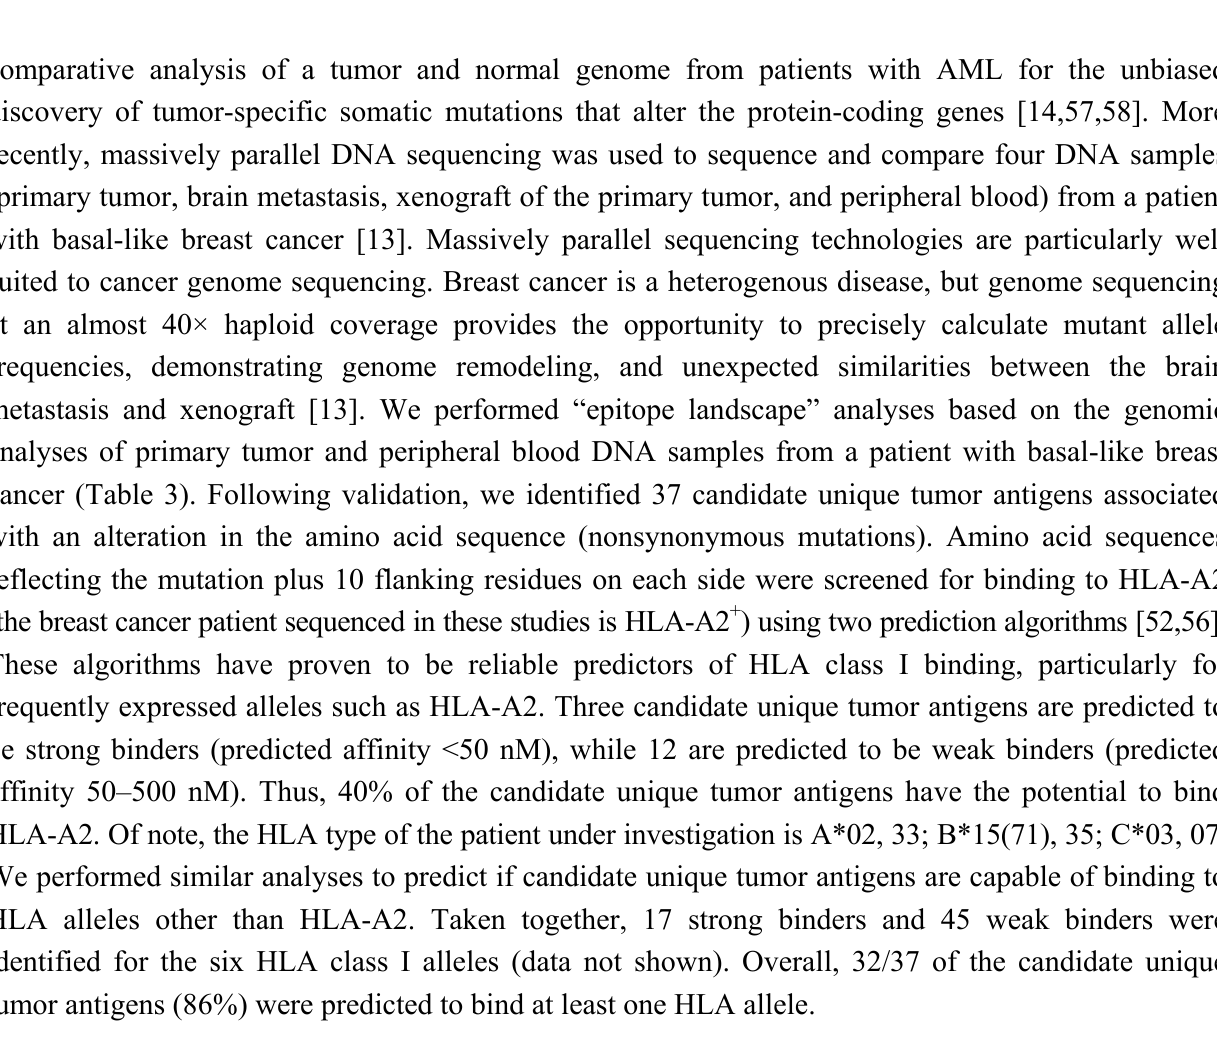
Table 3. Unique tumor antigens identified through breast cancer genome sequencing and predicted binding to